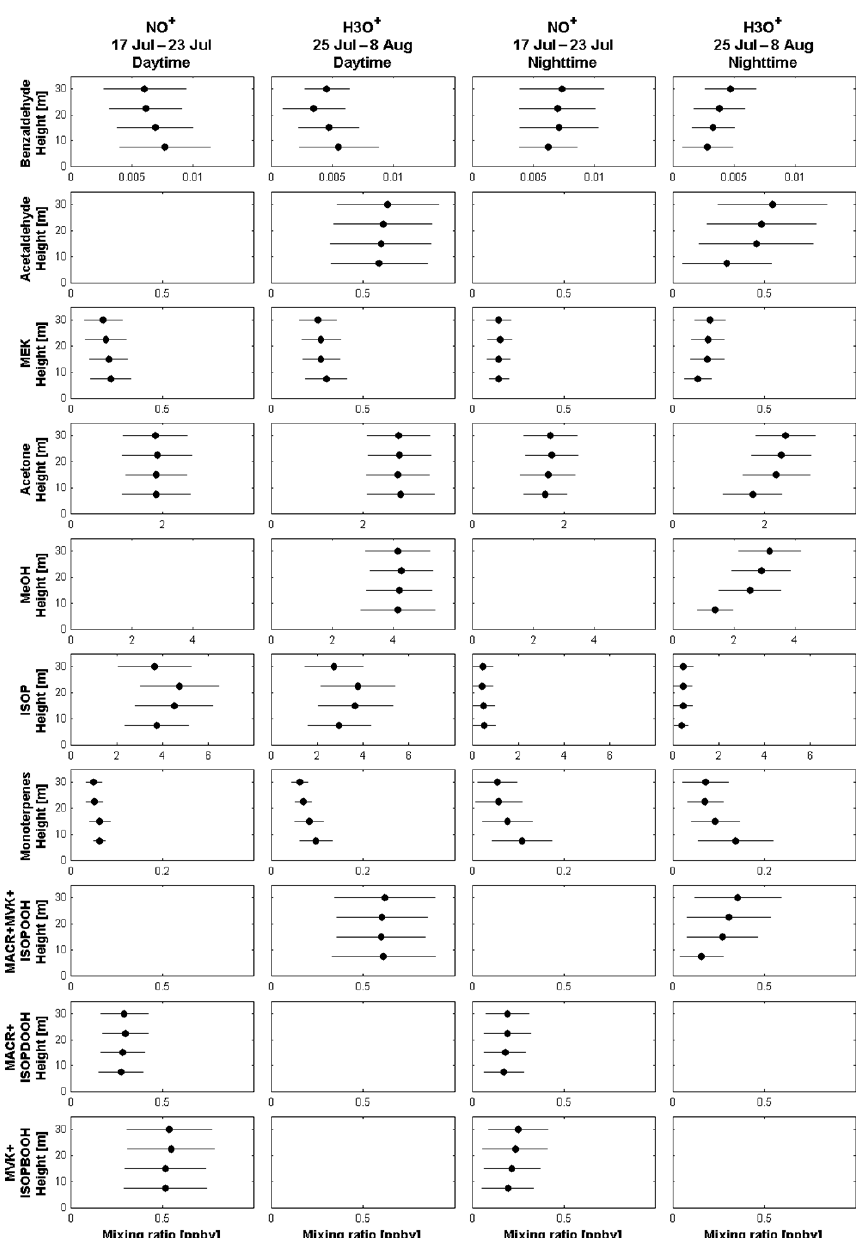
Figure 2. Average daytime and nighttime vertical concentration profiles. Measured VOC concentrations at various heights within and above canopy are reported. Horizontal bars represent standard